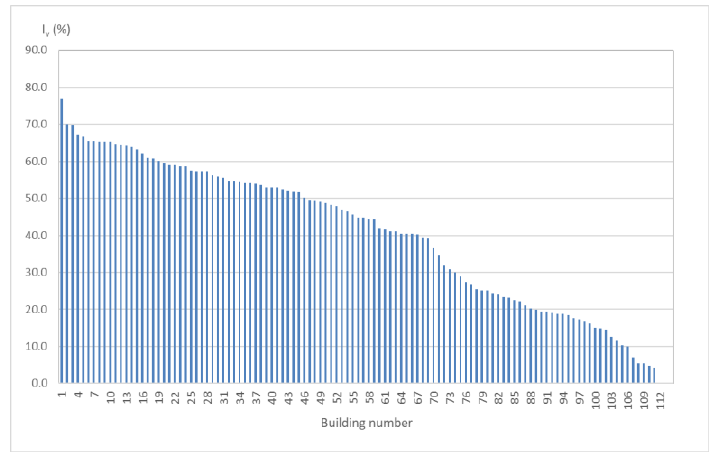
Figure 6. Distribution of I v for a sample of 111 buildings.